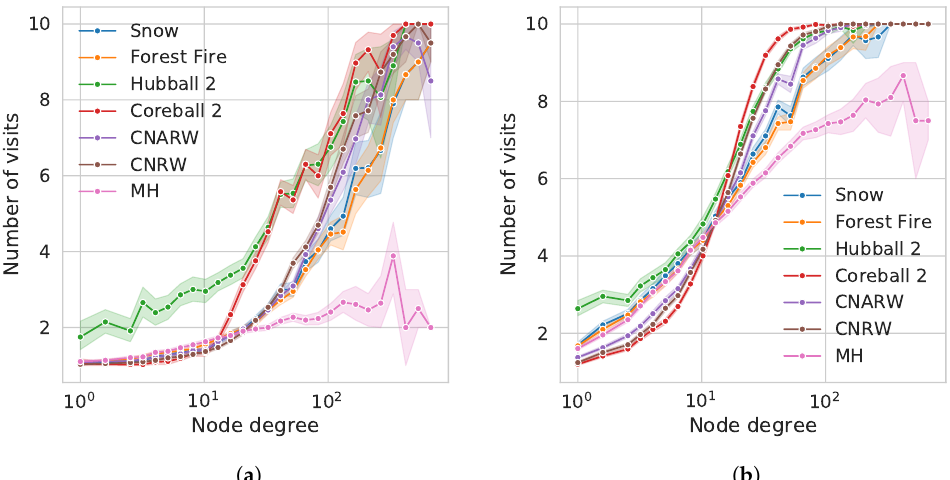
Figure 5. Probability to visit a node with respect to its degree on the Facebook graph for several sampling schemes. Fireball and Edgeball methods have been omitted from the graphs for clarity. The experiment starts using four randomly-selected initial nodes, and is repeated 10 times. The Snowball result is plotted as an indicator of the value for the non-random case, with probability 1. Note that for the Snowball, although the propagation is non-random, the initial starting points are randomized between each run. ( a ) Ball with 2000 nodes (approx. 4 layers of Spikyball) and a selection of 10% of the nodes at each layer ( b ) Ball with 8000 nodes (approx. 8 layers) and the same selection rate. On the left, most of the nodes were visited only once during the 10 tests except for the highest degree ones (above 100 connections). The large 95% confidence interval indicates high variations in the results. On the right, The curve shows a more robust outcome with lower fluctuations and high probability to be visited when a node has a degree larger than 50 (more than 8 visits out of 10). Spikyball-based methods behave in a stabler manner than alternative sampling